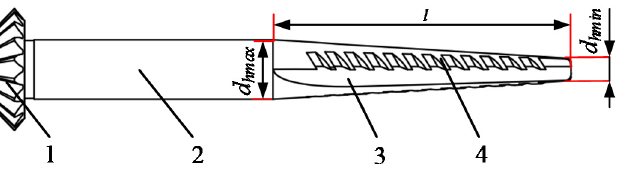
Figure 5. The overall structure sketch of the spindle. 1. Bevel gear, 2. spindle rod, 3. spindle head, 4. hook tooth.